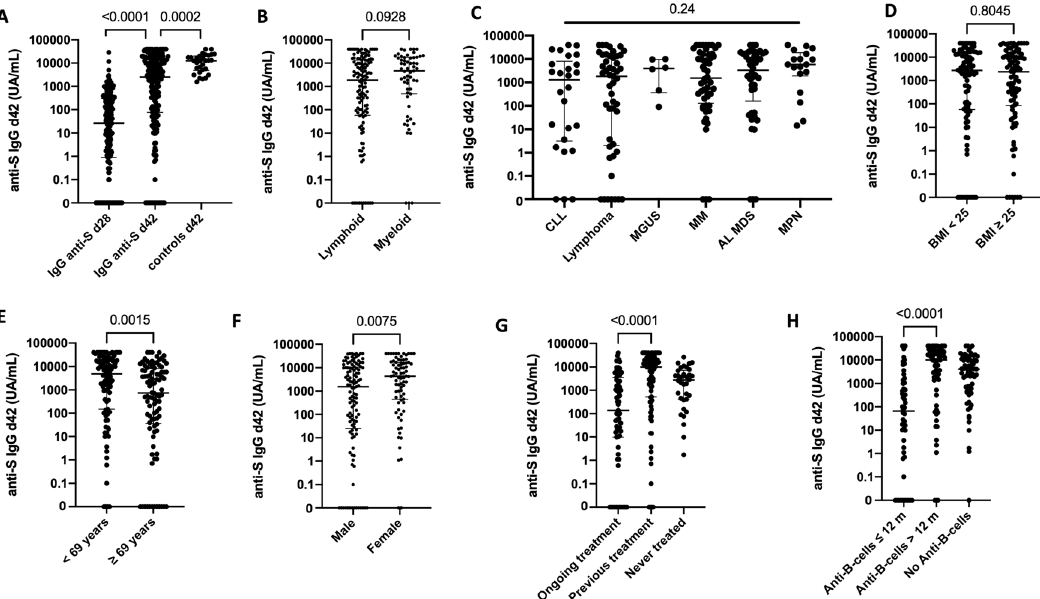
Fig. 2 Serological response to COVID-19 BNT162b2 vaccine. Anti-S IgG antibodies were evaluated before the second BNT162b2 vaccine dose at day 28 (d28) and 2 weeks later at day 42 (d42). A anti-S IgG antibody at d28 and d42 in patients ( n = 195) and at d42 in healthy